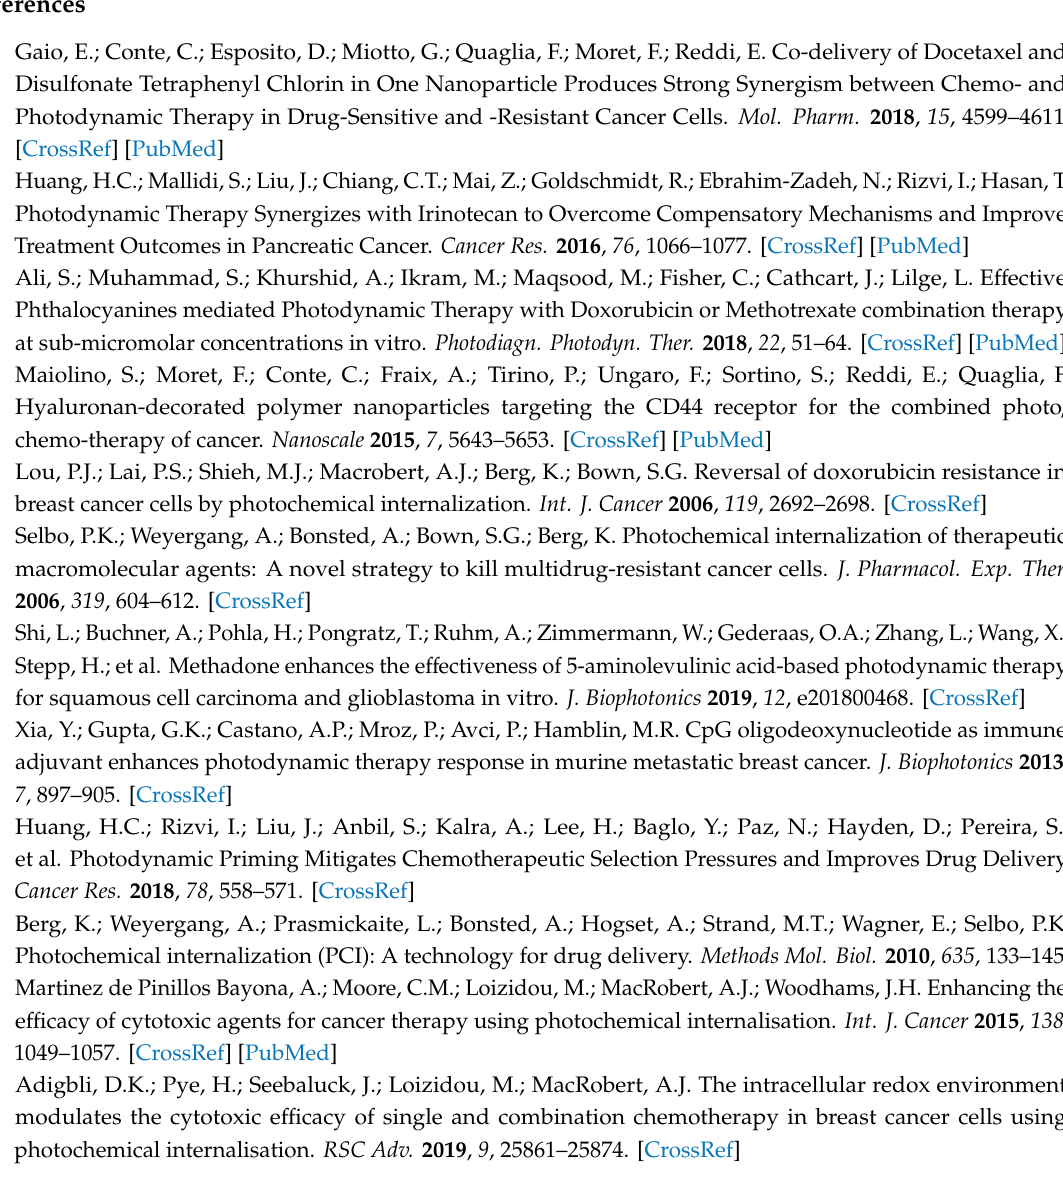
Figure S1: Live-Dead images of SKOV3 3D cultures post Dactinomycin only (2nM) and combination treatment using di ff erent light conditions, Figure S2: Live-Dead images of HEY 3D cultures post Dactinomycin only (2nM) and combination treatment using di ff erent light conditions, Figure S3: Live-Dead images of HEY 3D cultures post PDT (0.4 µ g / mL) (B), dactinomycin only (1nM) (C) and combination treatment (D) and 5 minutes of light